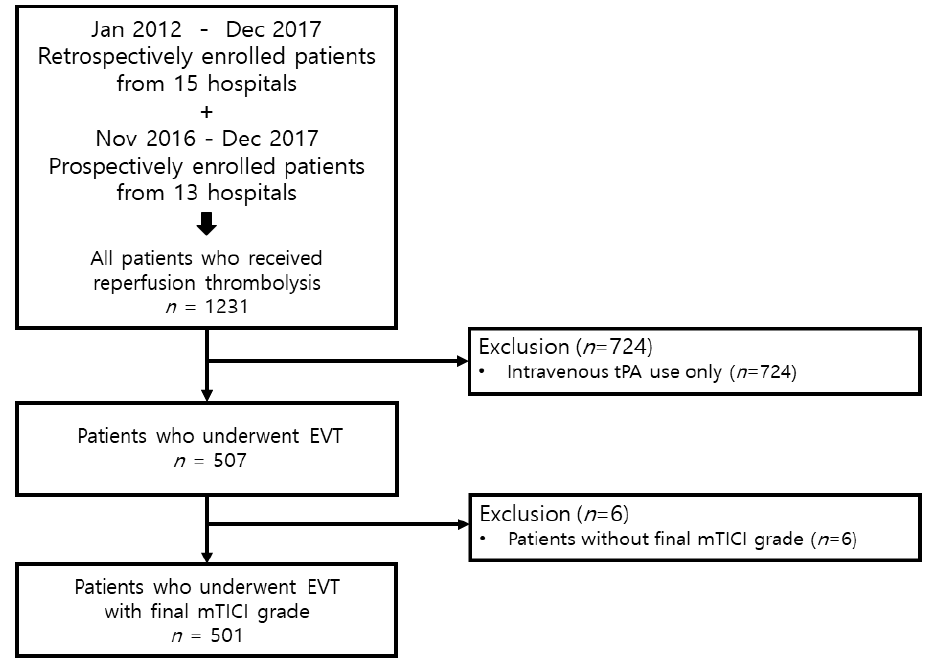
Figure 1. Patient selection strategy used in the study. tPA, tissue plasminogen activator; EVT, endovascular thrombectomy; mTICI, modified thrombolysis in cerebral infarction. Stroke severity was defined using the National Institutes of Health Stroke Scale (NIHSS) score, and the neurologic change after 24 h of EVT was defined as the difference between the initial NIHSS score and the NIHSS score at 24 h (Initial NIHSS score—NIHSS score at 24 h = change in NIHSS score after 24 h). Therefore, if this value was positive, it means neurological improvement, 0 means no improvement, and negative means neuro- logical worsened. Time parameters of EVT were acquired from onset-to-start of EVT (onset to puncture time) and administration of intravenous (IV) thrombolysis (tissue plasminogen activator, tPA) to start of EVT (needle to puncture time) [14]. In case of unclear symptom onset time, the last normal time (LNT) when the patient was asymptomatic was